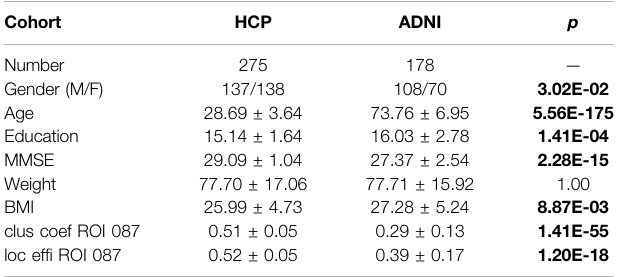
TABLE 1 | Participant characteristics in HCP and ADNI genetic association